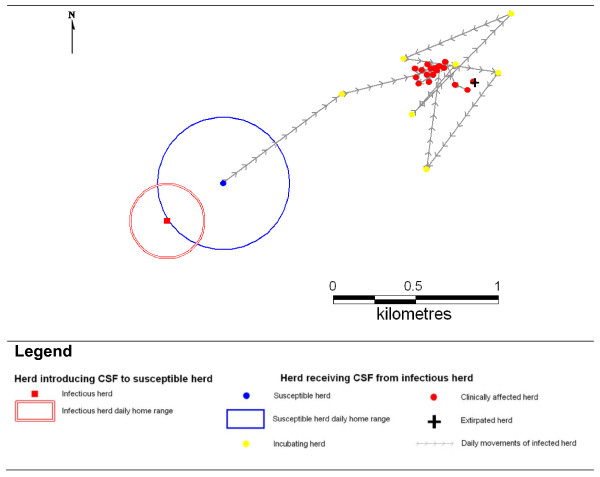
Representation of a typical disease transmission event and subsequent daily movements of the newly infected herd in the process model. Explanation: an infected herd (red square) and susceptible herd (blue circle) have overlapping daily home ranges (red and blue circles respectively). Classical Swine Fever transmission may occur according to an arbitrary probability. Following infection the incubating herd continues to move normally for several days (yellow dots) before becoming clinically affected (red dots) with shortened daily movements and eventually having all herd members killed (black cross). This infected herd does not contact another herd and CSF is not transmitted to another herd.